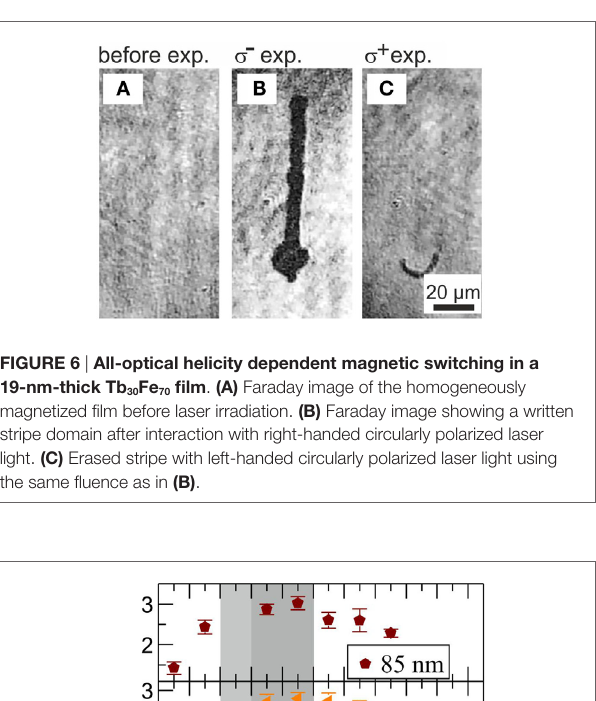
FigUre 8 | (a) Remanent magnetization M R and (B) uniaxial magnetic anisotropy K u both at room temperature of Tb–Fe films of various thicknesses and composition. The dotted line indicates the area where AOS occurs.